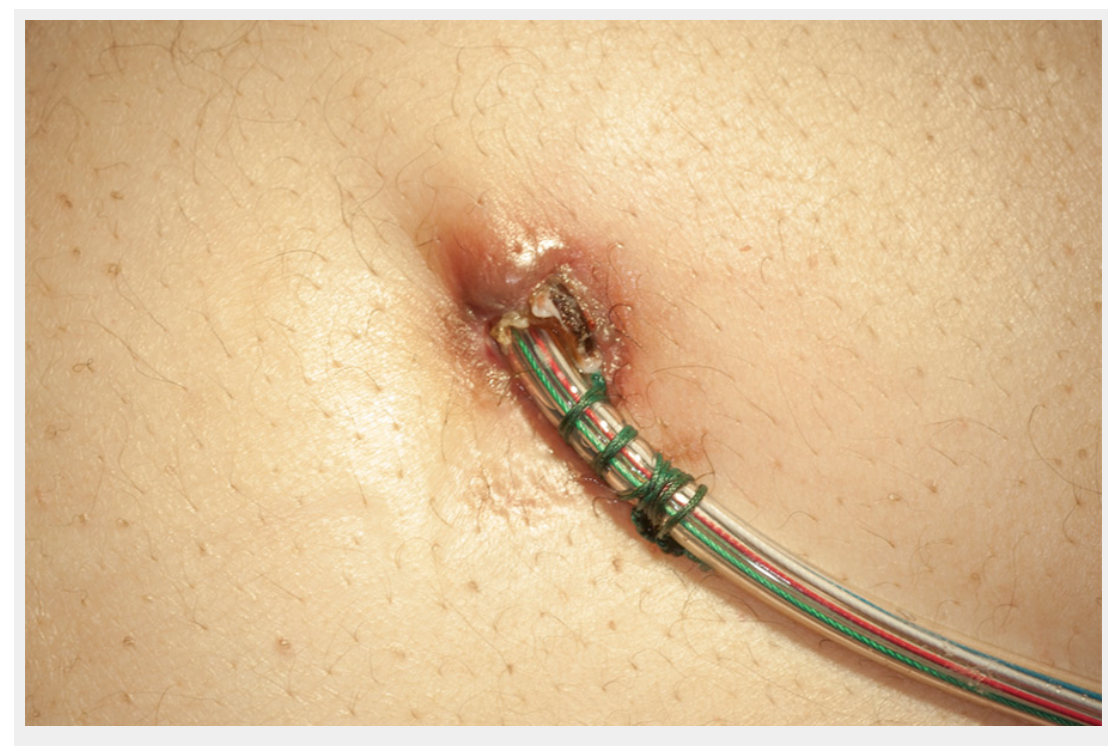
Figure 5 Driveline pierces the skin. This area is at high infection risk even if appropriate care is